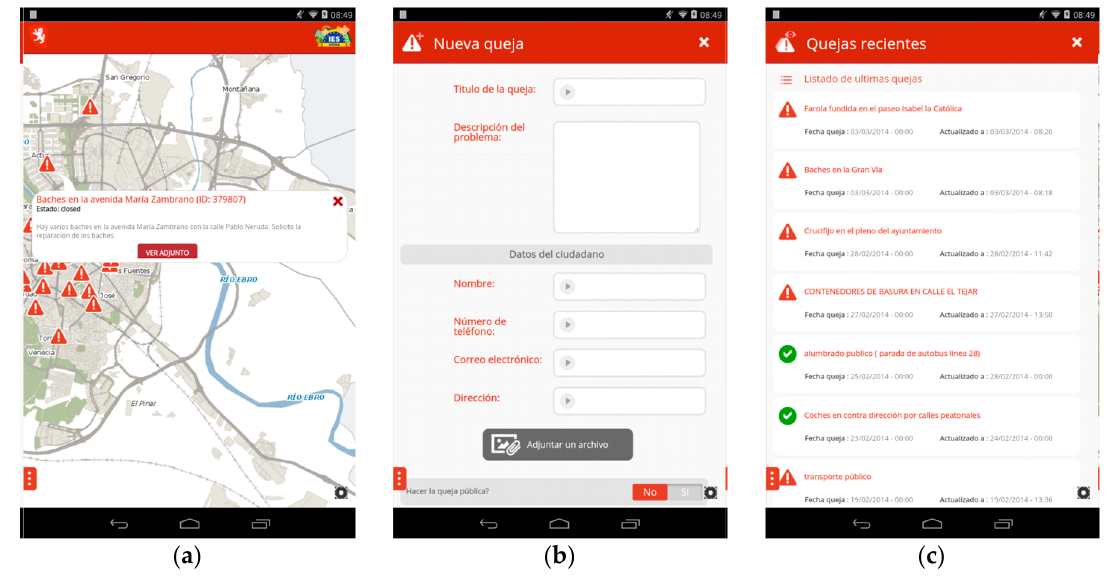
Figure 12. ( a ) Map showing current complaints and suggestions from Zaragoza’s city; ( b ) Form